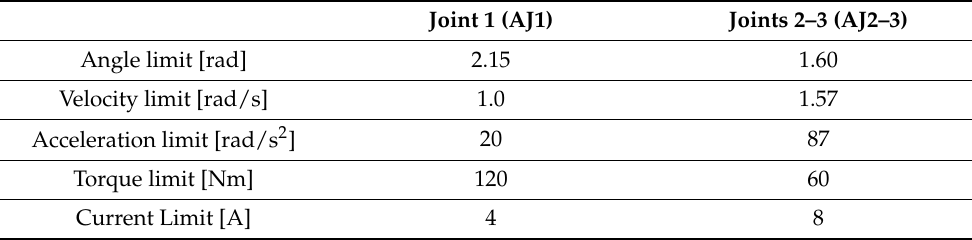
Table 1. SMM active joints limit